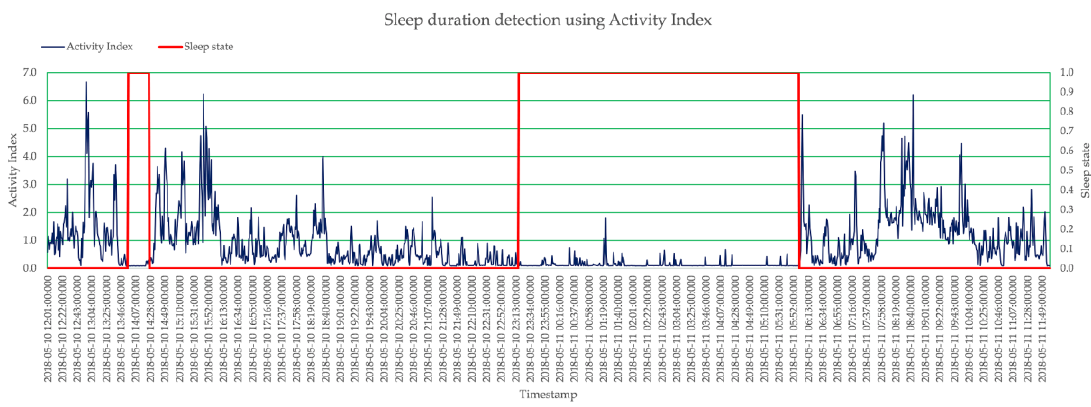
Figure 3. 24 h minute AI pattern with sleep state identified.